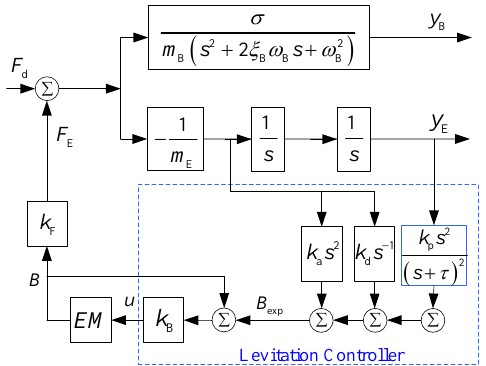
Figure 9. The block diagram of maglev vehicle-bridge system with estimator.